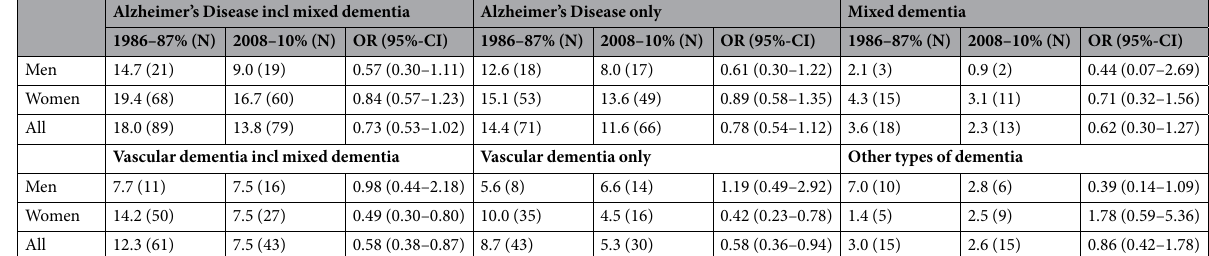
Table 3. The prevalence of types of dementia in 85-year- olds examined in 1986–87 and 2008–10. The sample examined in 1986–87 is reference group for all odds ratio (OR). Other types of dementia 1986–87: four